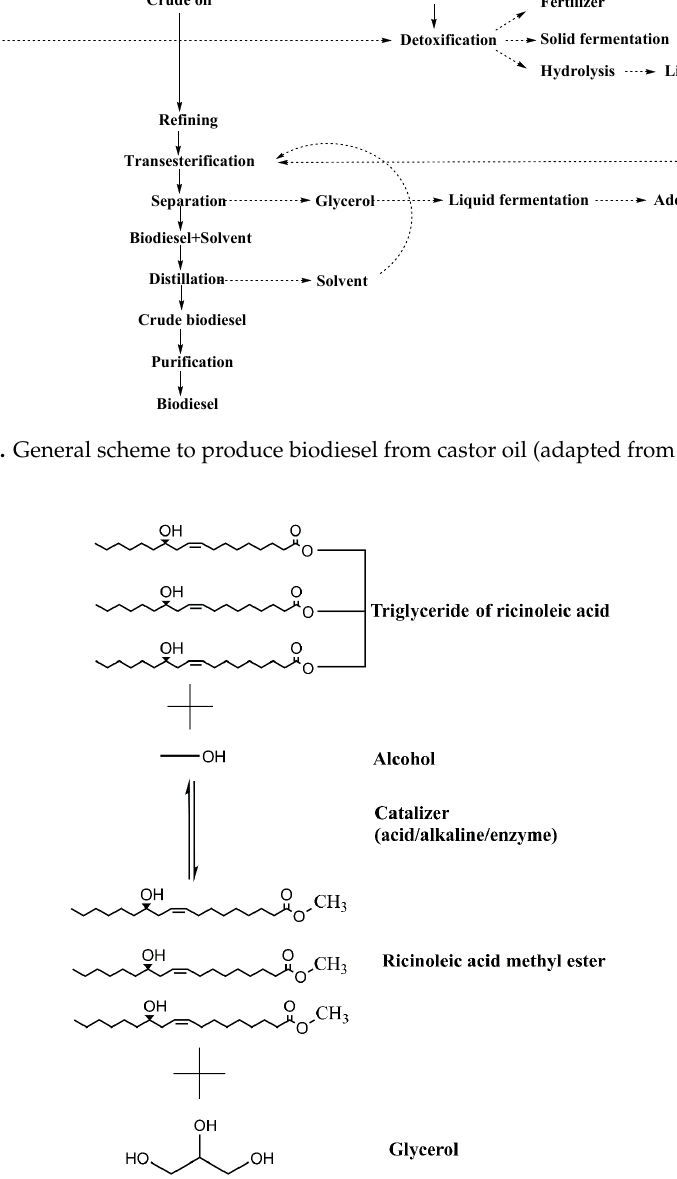
Figure 3. Transesterification reaction during biodiesel production using castor oil as feedstock.